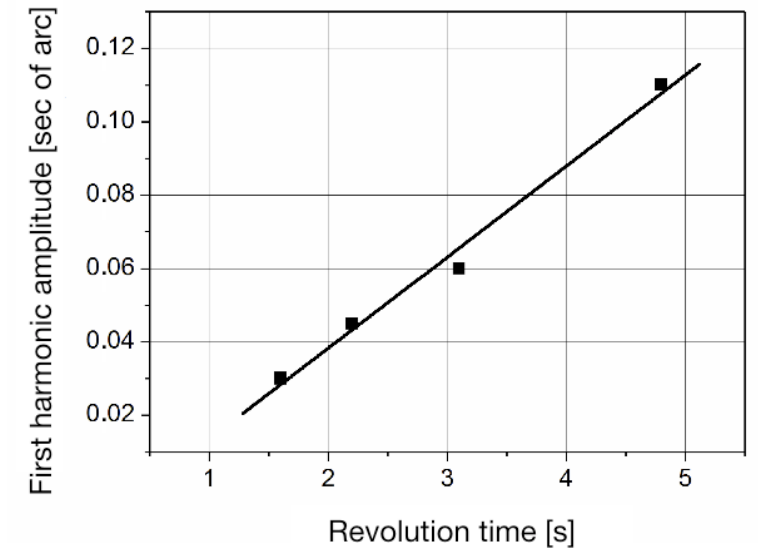
Figure 4. The dependence of the amplitude of the first harmonic on the revolution time.